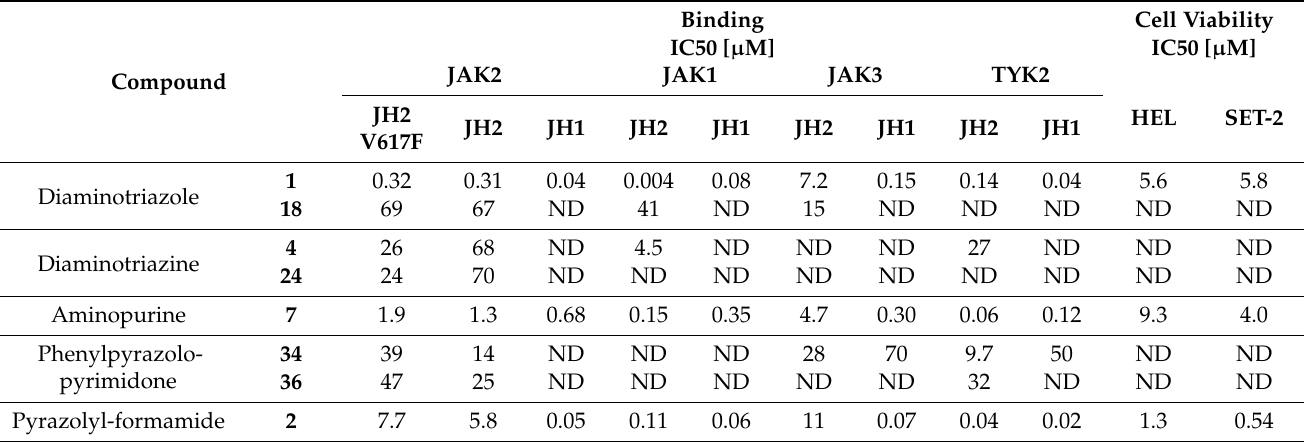
Table 2. JAK- and domain-selectivity of selected hits or analogs and effects on MPN cells. Binding of selected hits or analogs to JAK2 JH2 V617F mutant, JH2 and JH1 domains of JAK family members, and effect on cell viability of MPN cell lines HEL and SET-2. Data is presented as IC50 [ µ M] obtained by fitting dose vs. normalized response across multiple replica data sets ( n =